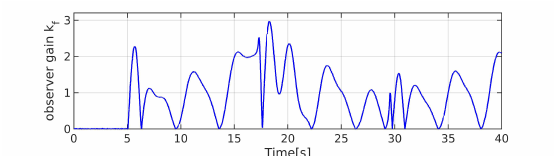
Figure 9. Observer gain of FASTESO during adaptation process with scalar a = 20.